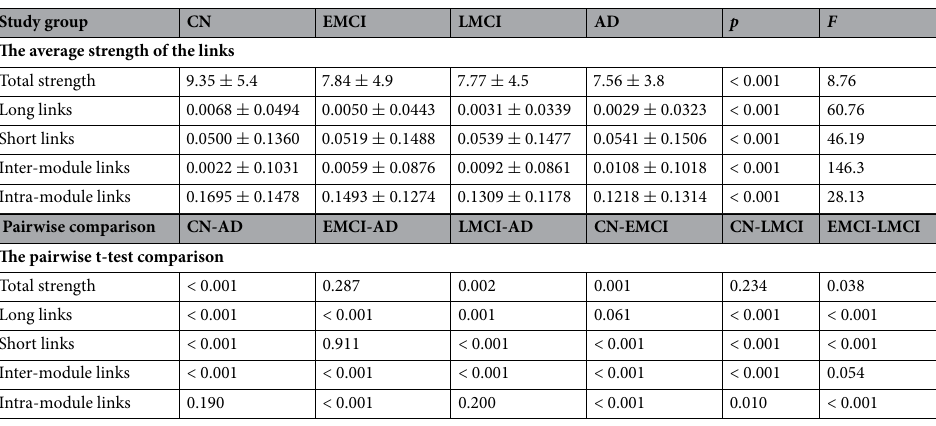
Table 1. General information about the distribution of the links of the study networks. The top table shows the average strength of the links, which are grouped into long or short links and inter-module or intra-module links. The significance of the pairwise differences is assessed using the t-test and is shown in the bottom